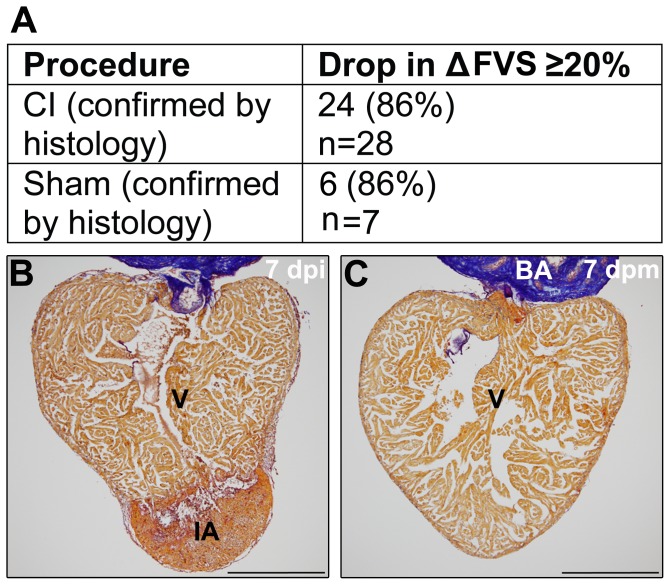
Correlation between histology of imaged hearts and echocardiographic analysis.
(A,B) Groups of animals in which cryoinjury was confirmed by histological AFOG staining after echocardiography. In 24 out of 28 fish, cryoinjury was diagnosed at 7 dpi by measurement of a drop of the RFVS ≥ 20% compared to the equivalent basal measurement. Only one from 7 sham-operated fish presented a drop in RFVS ≥ 20%. (C) Subsequent histological staining however did not support an alteration in the cardiac morphology or injury in any of the sham operated animals. BA, bulbus arteriosus; IA, injured area; dpi, days postinjury; dpm, days postmanipulation; V, ventricle. Size bars, 200 µm.